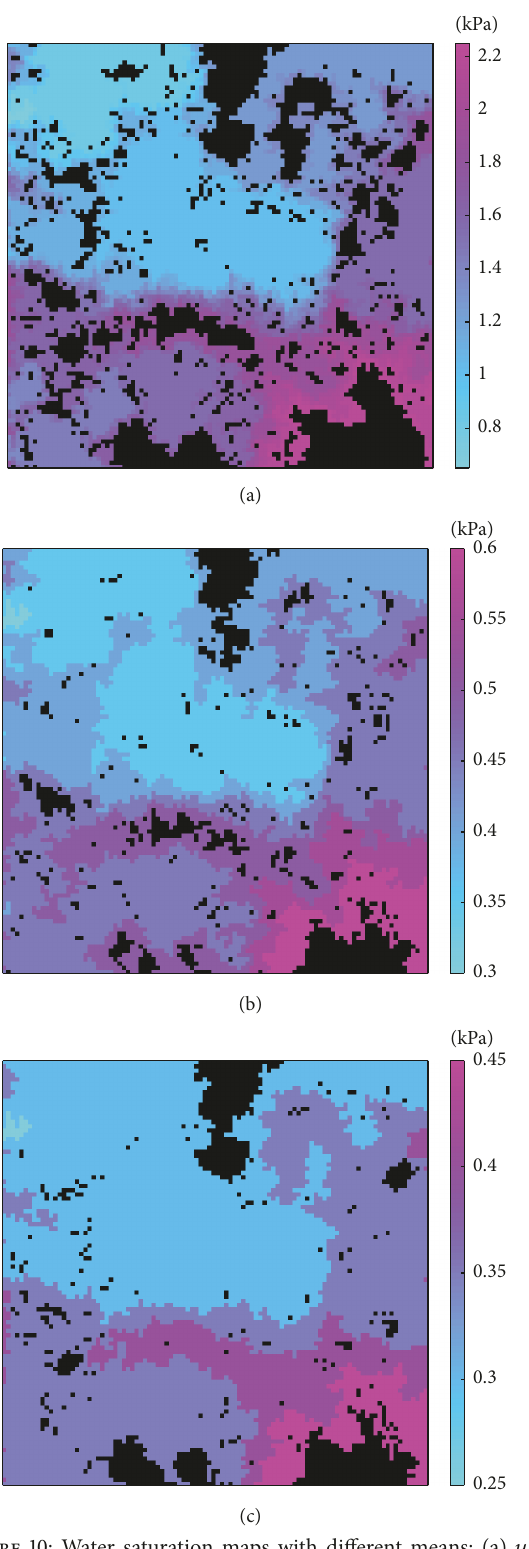
Figure 10: Water saturation maps with different means: (a) 𝑢 = 0.15 mm; (b) 𝑢 = 0.40 mm; (c) 𝑢 = 0.50 mm.